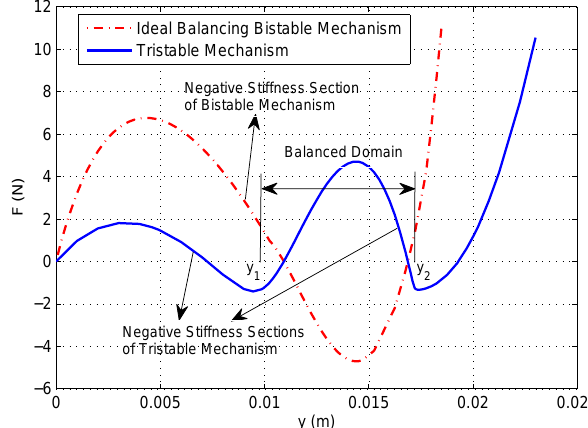
Figure 3. The force-displacement characteristics of the gravity compensated robot. Note that the force-displacement curve for the constant-force mechanism is plotted using Eq. ( 1) instead of its sim- plified version, Eq. (2).